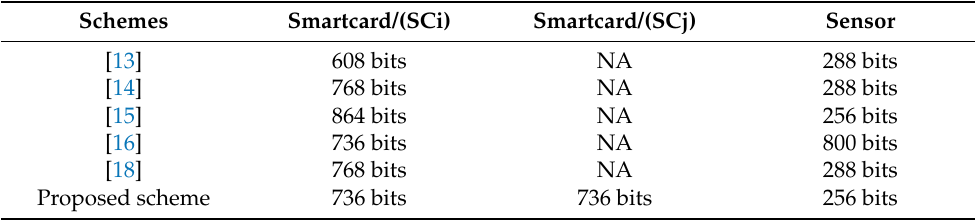
Table 10. Storage size cost analysis.